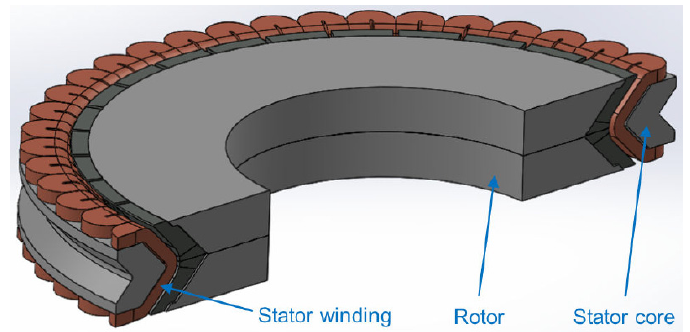
Figure 18. Dual ‐ conical air ‐ gap PMSM with components fabricated via AM, reproduced with per ‐ mission from [179]. Copyright ASME